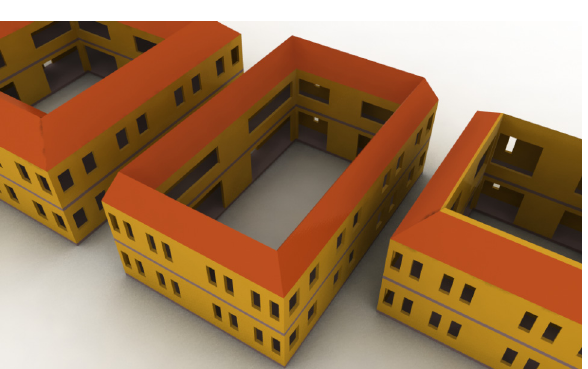
Figure 10: Residential atrium